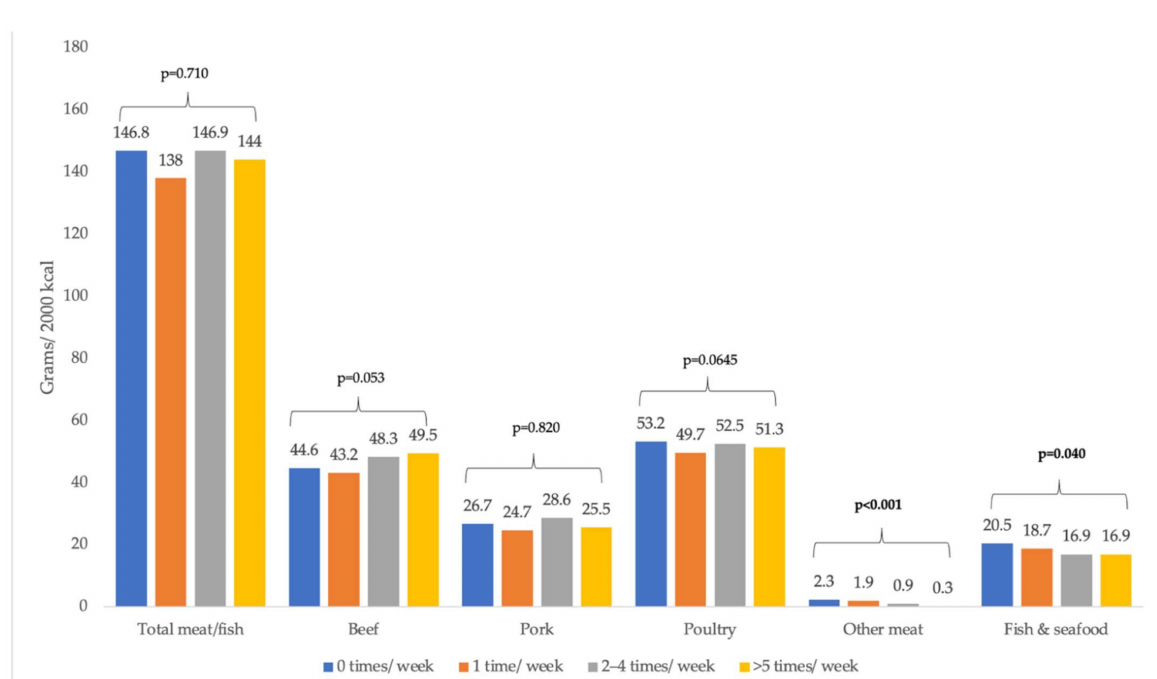
Figure 2. Meat and fish consumption (grams per 2000 kcal) by cooking frequency, NHANES 2007–2010. Note: Based on post estimation margins after GLM models with gamma family and log link adjusted for age, sex, race/ethnicity, income, education, employment status, and household size. Other meat includes: sheep, goat, rabbit, and game. Six separate models were run for this figure, one for each type of meat and one overall model for the total consumption amounts. p -value is for the linear trend.